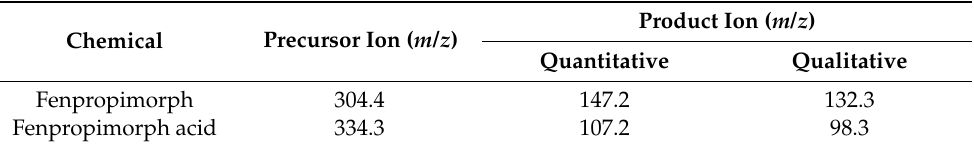
Table 1. Instrumental conditions for analysis of fenpropimorph and fenpropimorph acid in multiple reaction